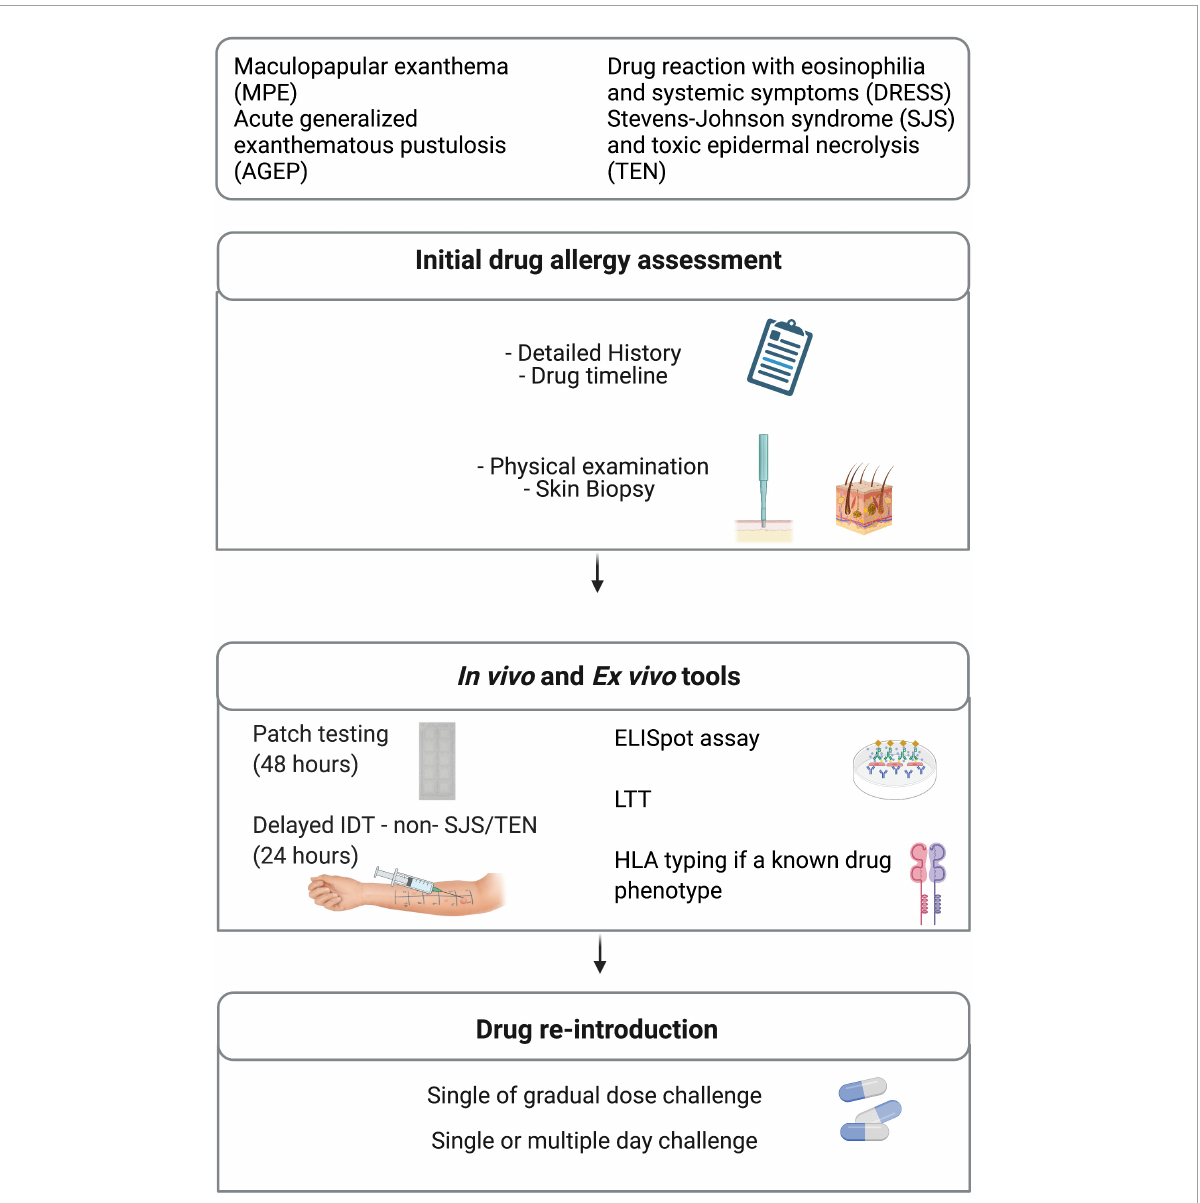
FIGURE3 Diagnostic management. ELISpot, enzyme-linked immunoSpot; HLA, human leukocyte antigen; IDT, intradermal testing; LTT, Lymphocyte transformation test.